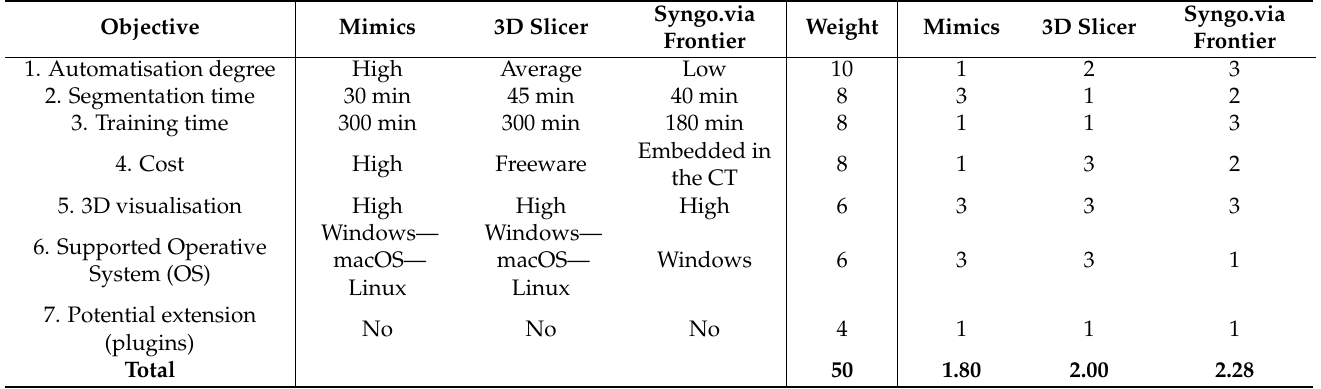
Table 5. Usability evaluation of the three segmentation software